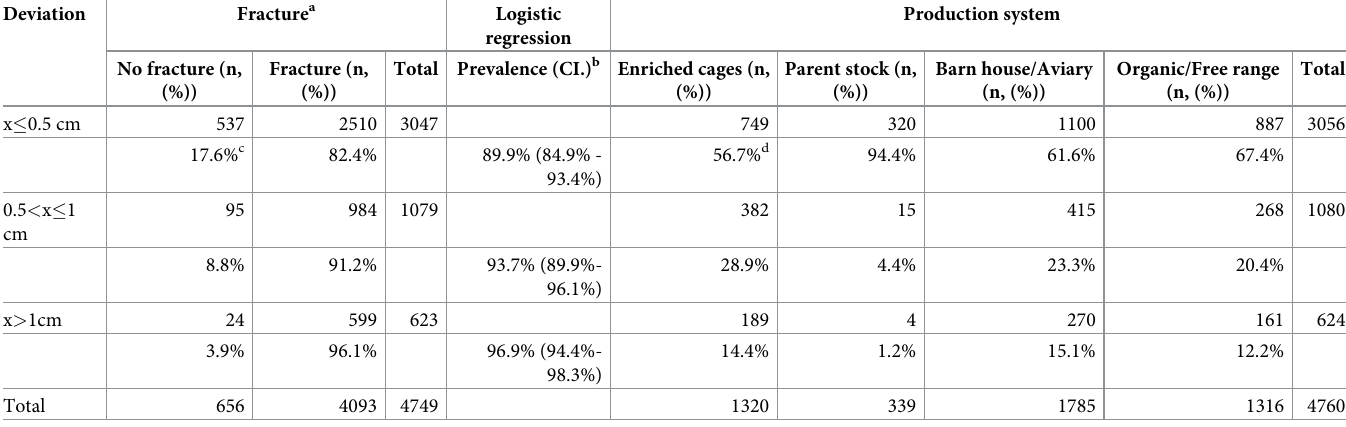
Table 6. Association between deviation of keel bone and fracture across all flocks and between deviation and production system.